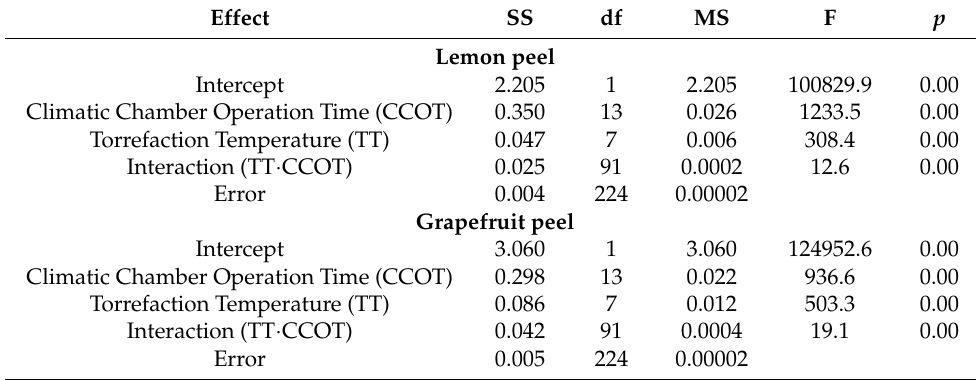
Table 8. Results of analysis of variance (two-way ANOVA) for the dependent variable